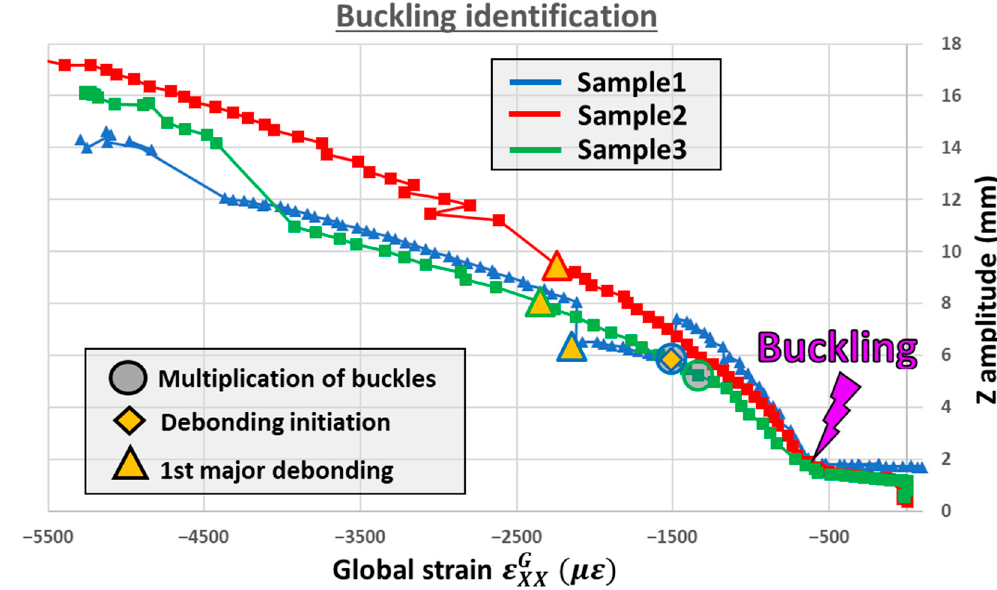
Figure 27. Identification of buckling for the three tests considered.